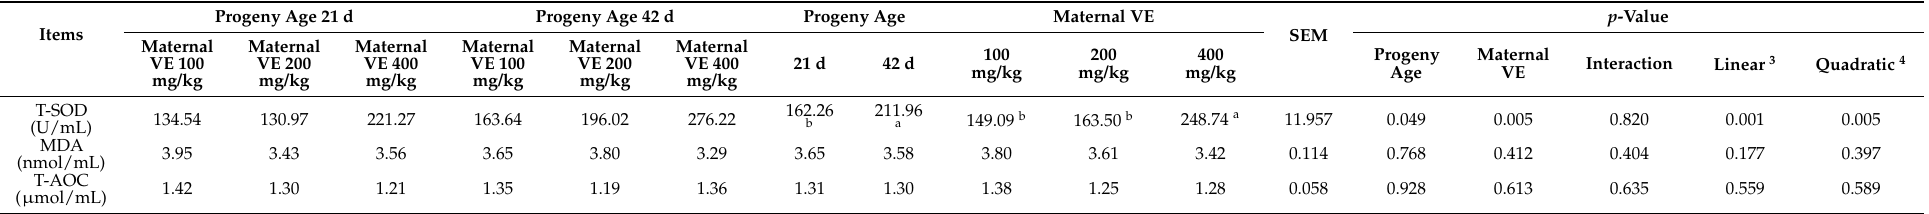
Table 5. Effects of maternal dietary vitamin E supplementation and progeny age on the serum antioxidant status of offspring hatched from stored eggs (trial 2) 1,2 .